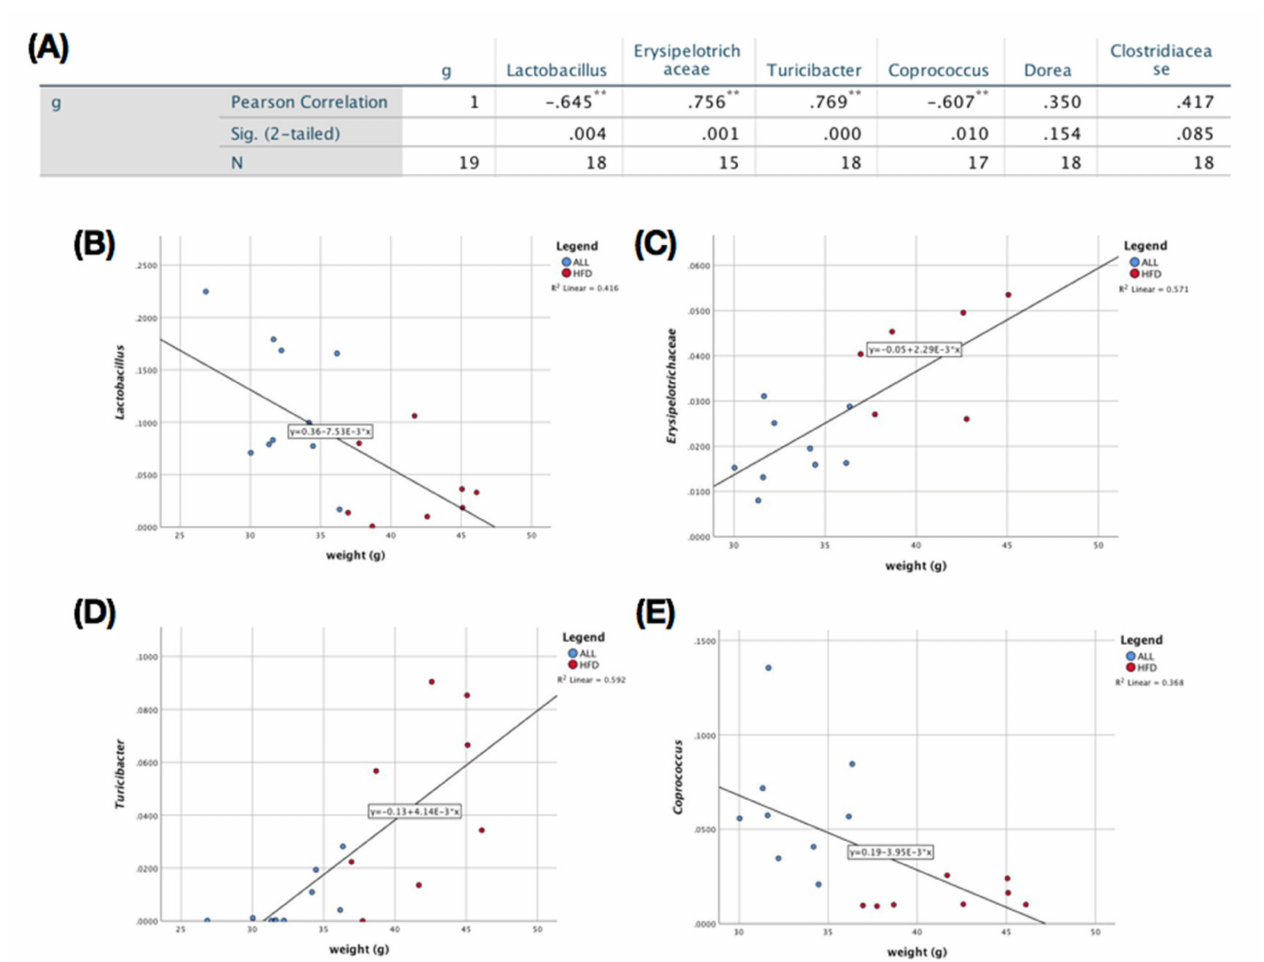
Figure 5. Correlation of microbiota with body weight. ( A ) Significance chart for Pearson’s correlation between microbiota and body weight. Correlation between body weight and the relative abundance of ( B ) Lactobacillus ; ( C ) Erysipelotrichaceae ; ( D ) Turicibacter , and ( E ) Coprococcus . HFD, high-fat diet (AIN-76, 20% fat, 1% cholesterol); ALL, (HFD + 5% D-allulose). Significance calculated through bivariate Pearson’s correlation analysis with body weight, * p < 0.05, ** p <